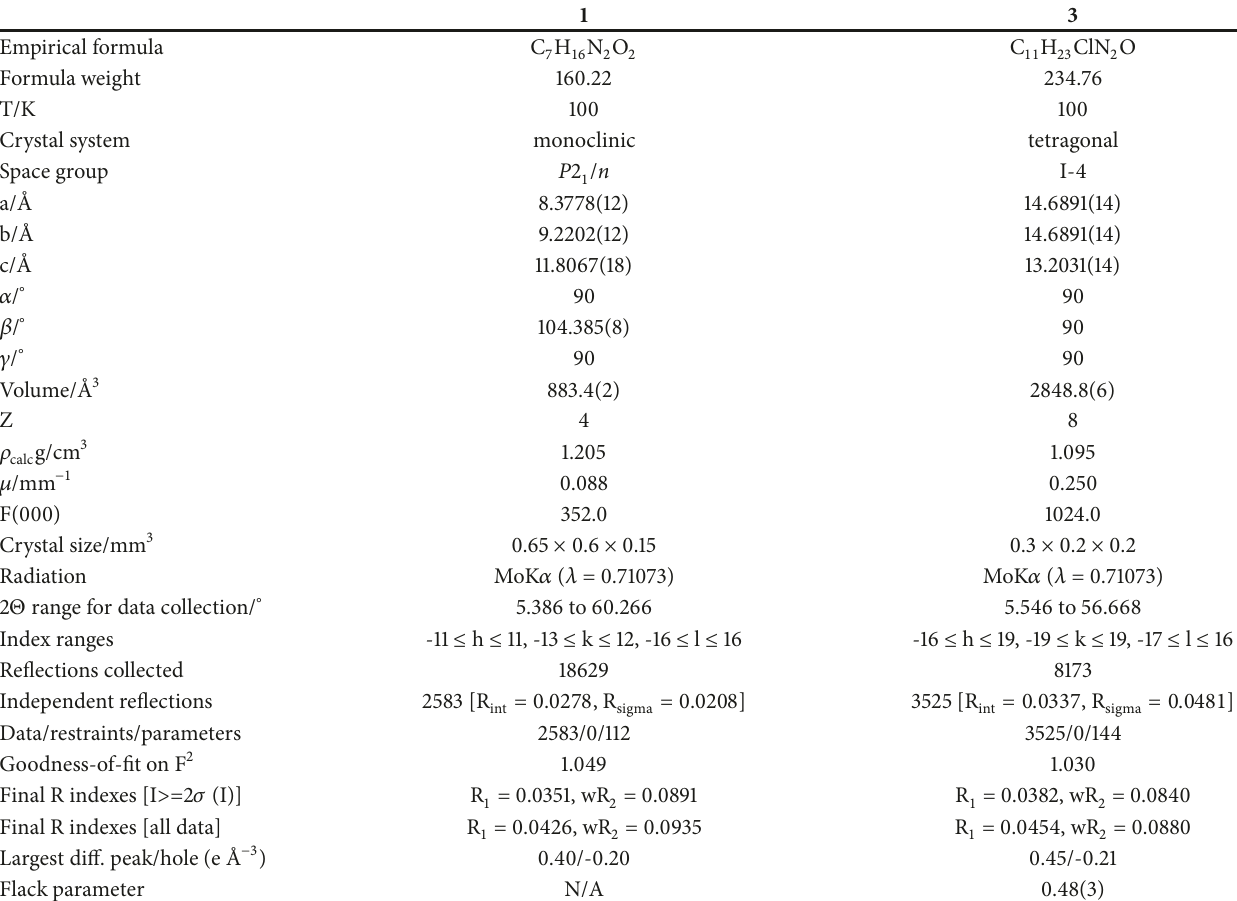
Table 1: Crystallographic data for 1 and 3